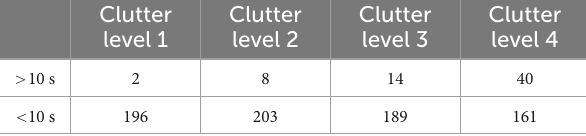
TABLE 1 Delayed reaction of varied clutter degrees.